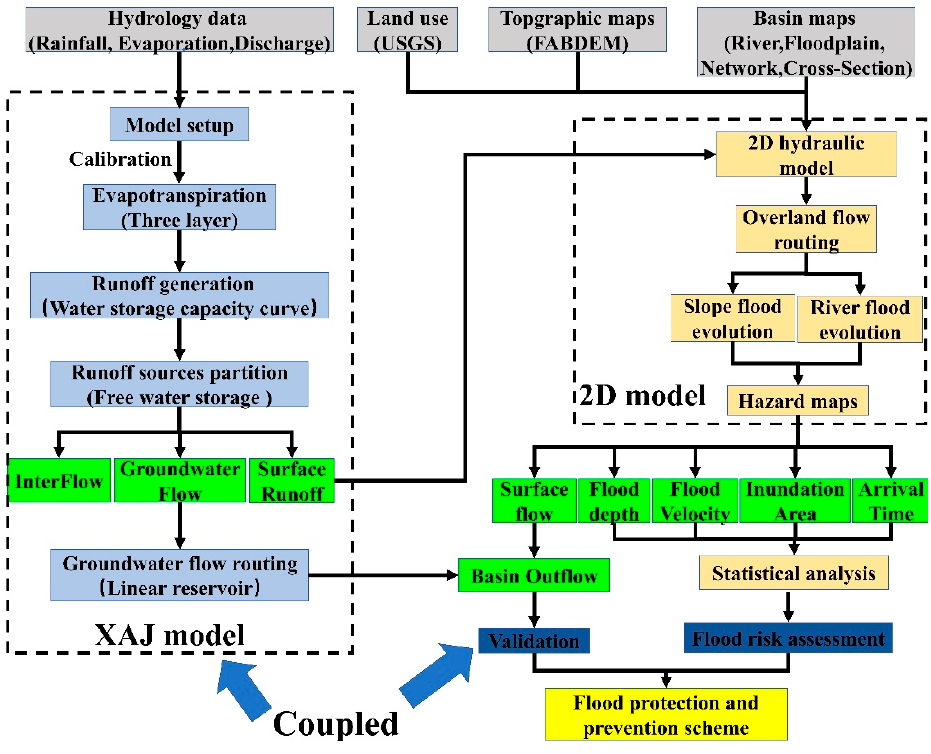
Figure 3. Flowchart of the coupled model.